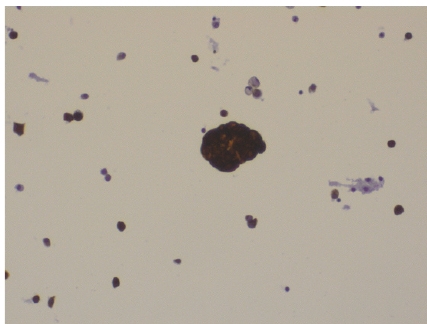
Figure 8: Immunostain for calretinin: atypical cell cluster in peritoneal washings of mesothelial origin.